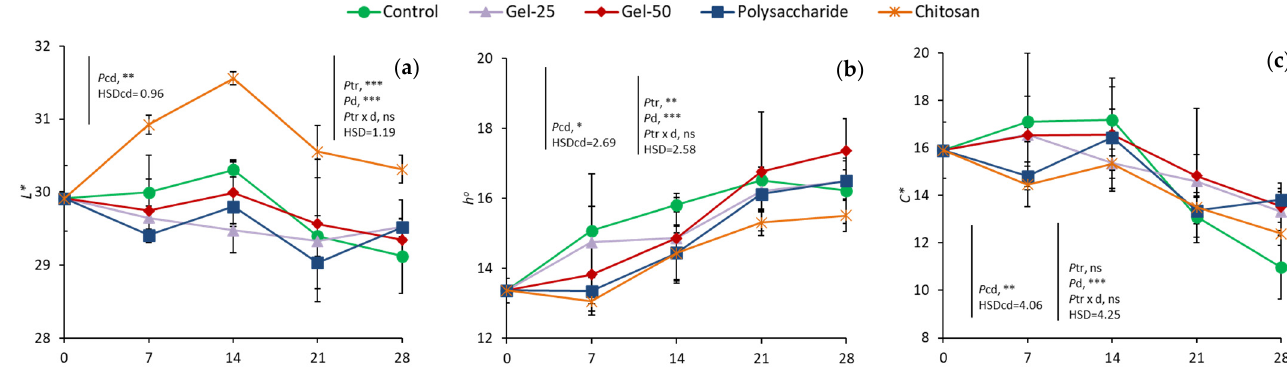
Figure 2. Effect of edible coatings on changes in peel color parameters, L* ( a ), hue angle ( b ) and C* ( c ), in cherries during storage. Points are means of three replicates of 10 cherries each; bars on the points, ± standard deviations. NS, non significant; * significant at p < 0.05; ** significant at p < 0.01; *** significant at p < 0.001. Pcd , probability of storage days in controls (one-way ANOVA from day 0); HSDcd, honest significant difference calculated from ANOVA. Ptr , probability of edible coating treatment; Pd , probability of storage days; Ptr × d , probability of interaction (two-way ANOVA from day 7); HSD, honest significant difference calculated from ANOVA.